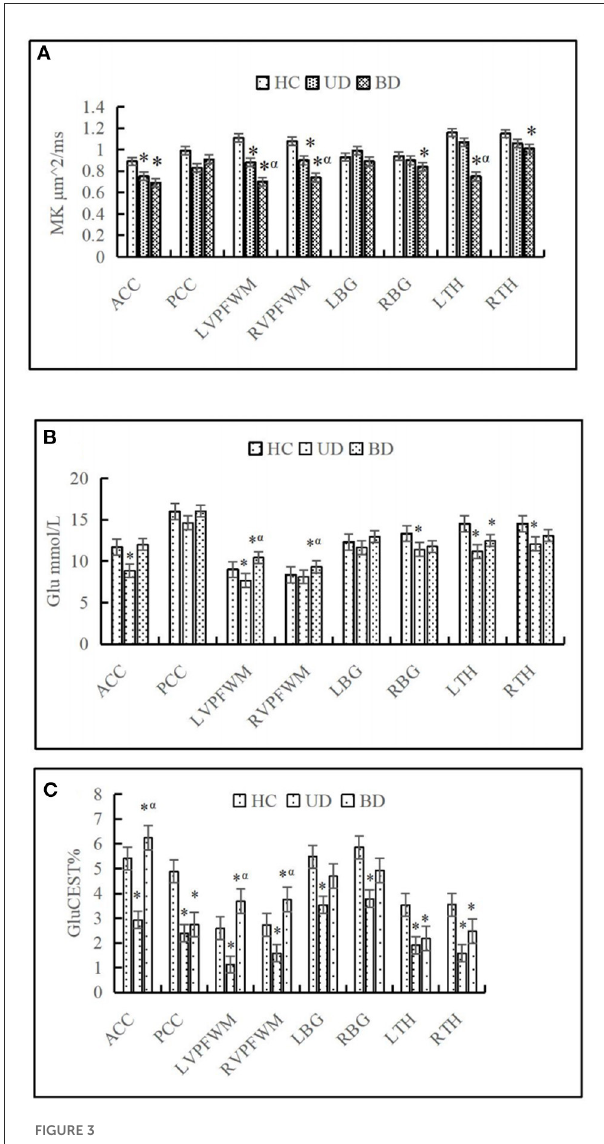
FIGURE3 Comparison of mean kurtosis (MK) (A) , glutamate (Glu) (B) , and chemical exchange saturation transfer (CEST) for glutamate (GluCEST%) (C) on eight brain regions in different groups. HC, Healthy control group; UD, unipolar depression group; BD, bipolar disorder group; ACC, anterior cingulate cortex; PCC, posterior cingulate cortex; DPWM, dorsolateral prefrontal white matter; TH, dorsal thalamus; BG, basal ganglia; L, left; R, right. * p < 0.05 was considered to indicate a statistically significant difference compared with the healthy control. α p < 0.05 was considered to indicate a statistically significant difference compared with the unipolar depression